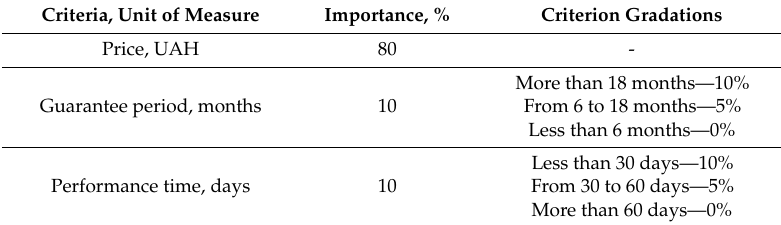
Table 3. Initial data for the calculation of the quoted price.